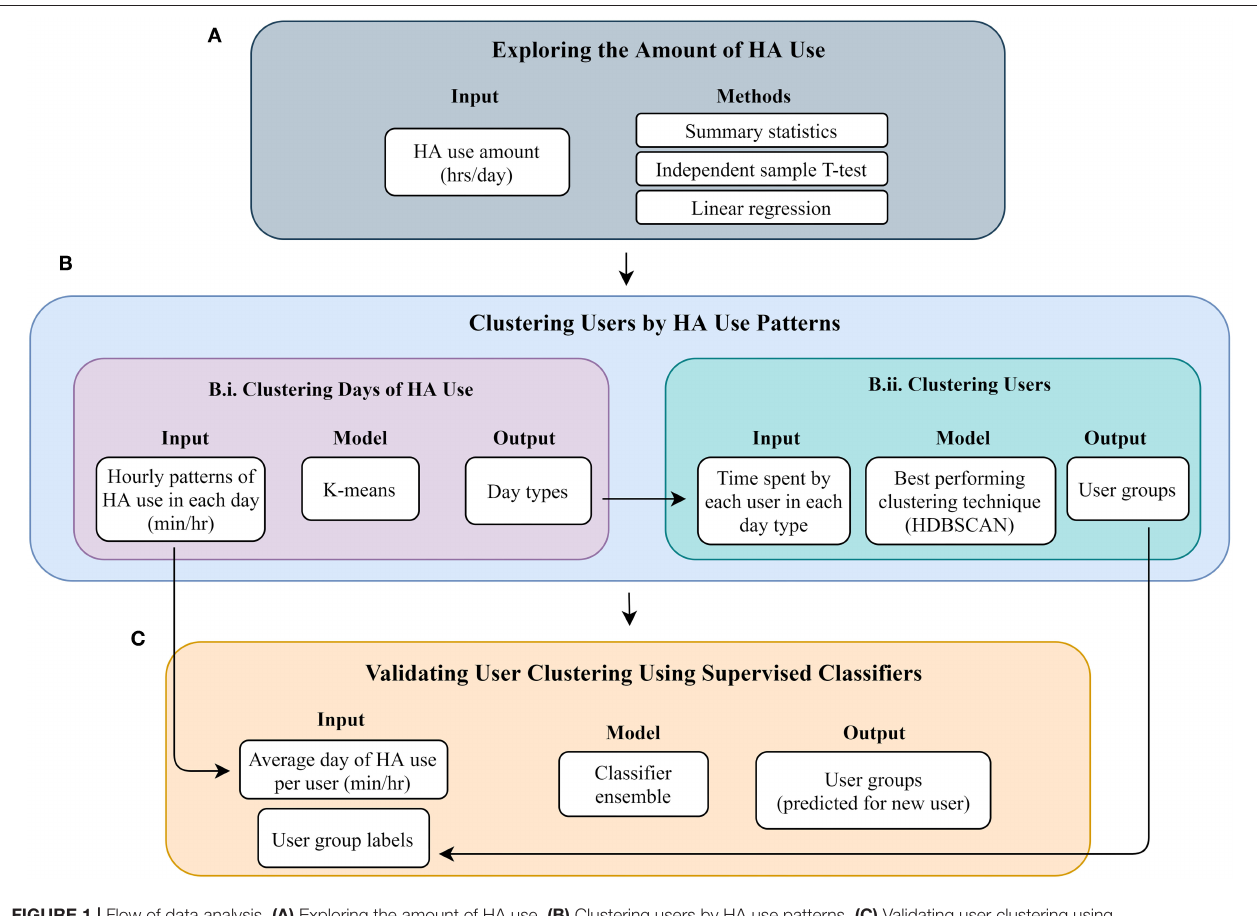
FIGURE 1 | Flow of data analysis. (A) Exploring the amount of HA use. (B) Clustering users by HA use patterns. (C) Validating user clustering using supervised